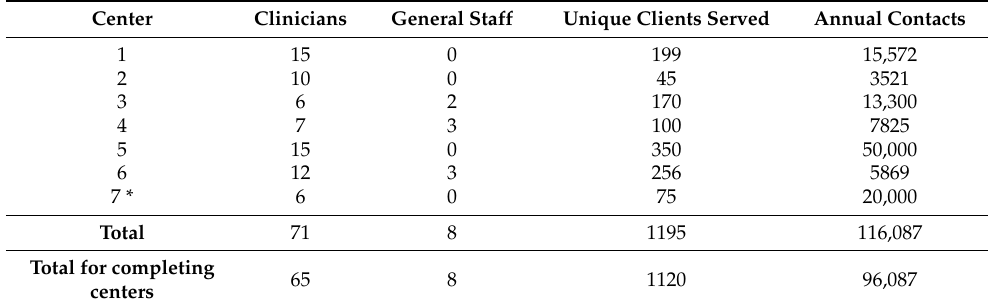
Table 1. Employees and annual client contacts in enrolled opioid addiction treatment centers in Texas,